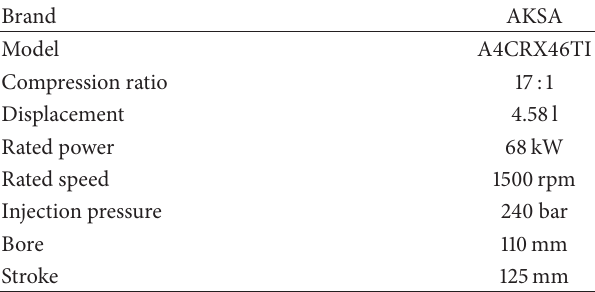
Table 3: Test engine